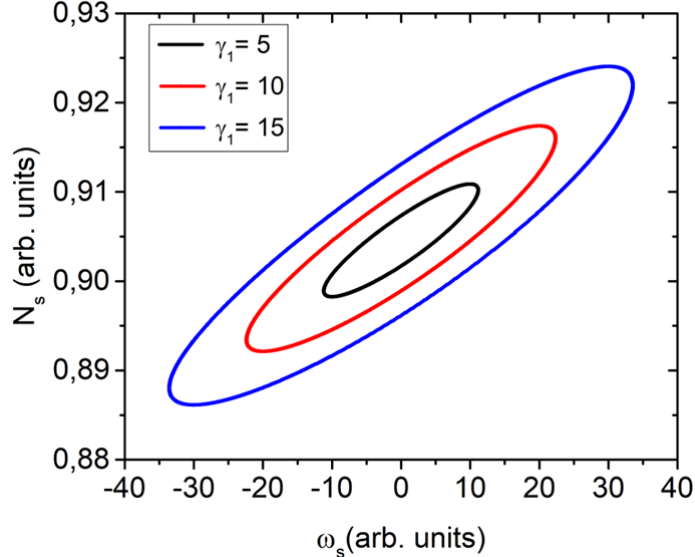
Figure 2. External cavity modes in the plane of (N s –  s ) for different values of feedback strength in conventional feedback branch. The feedback in filtered brunch is